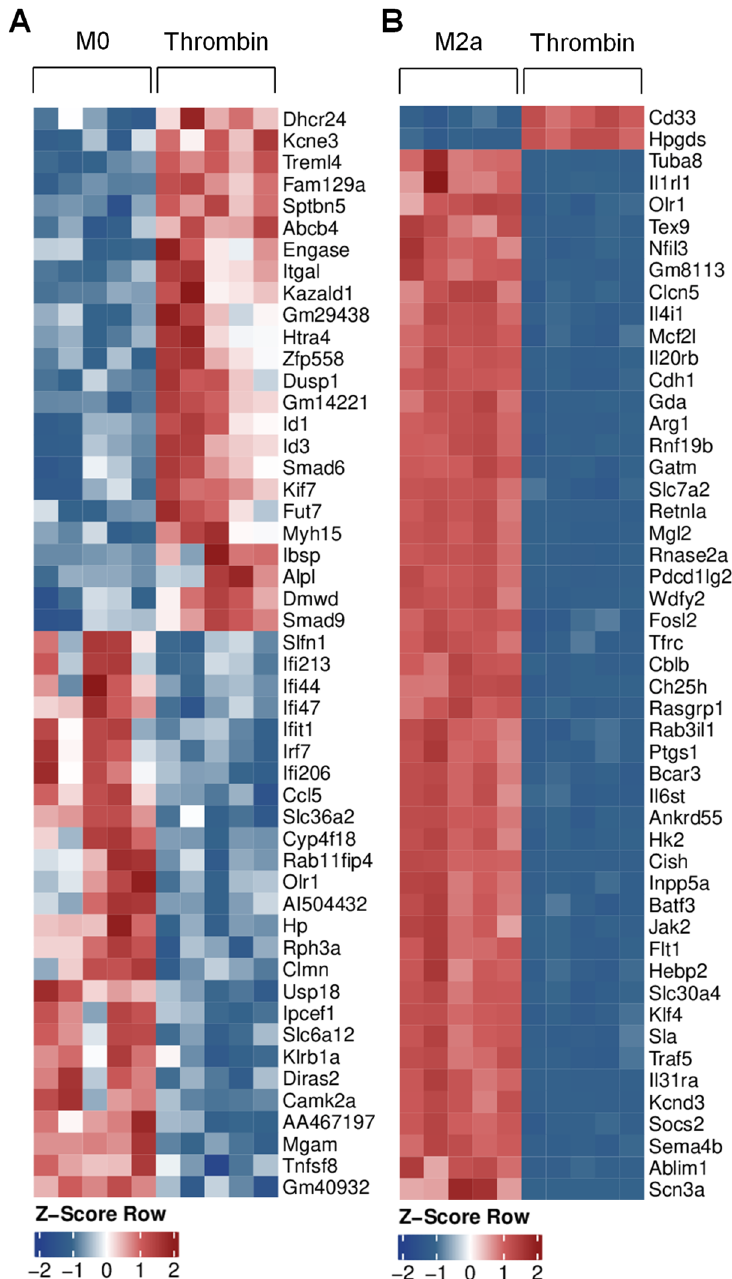
Figure 5. Thrombin-induced changes in macrophage gene expression. Murine bone-marrow-monocyte-derived macrophages (M0) were either treated with solvent, polarized to the M2a phenotype, or incubated with thrombin (0.1 U/mL, 24 h). ( A ) Top 50 differentially regulated genes between M0 and thrombin-treated macrophages; n = 5 mice. ( B ) Top 50 differentially regulated genes between M2a and thrombin-treated macrophages; n = 5 mice per